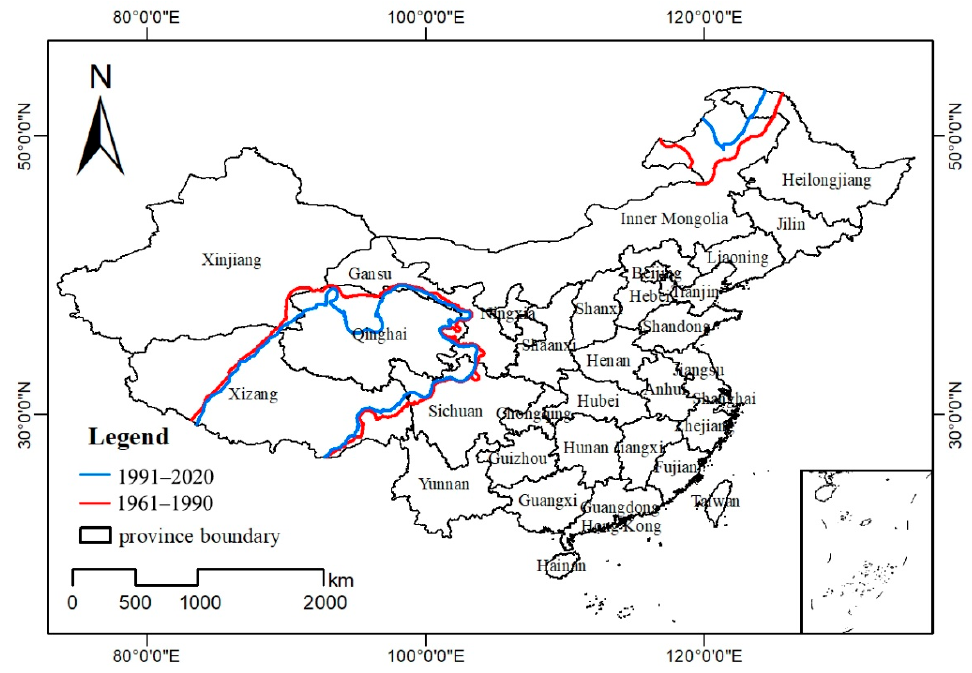
Figure 9. Potential northern planting boundary of spring maize during the period of 1961–1990 (red line) and 1991–2020 (blue line).